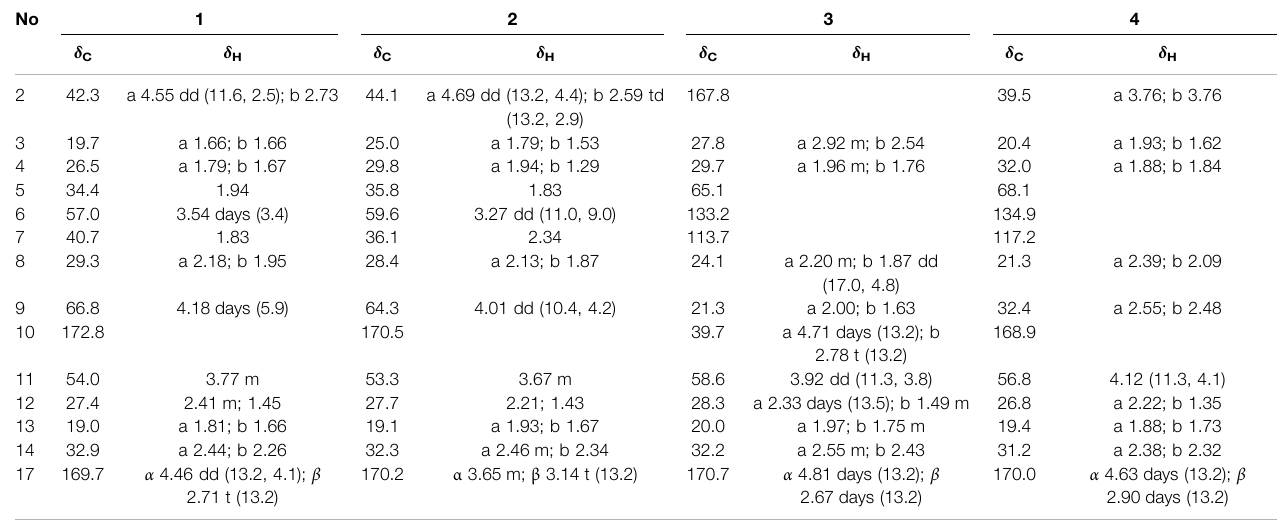
a Overlapped signals were reported without designating